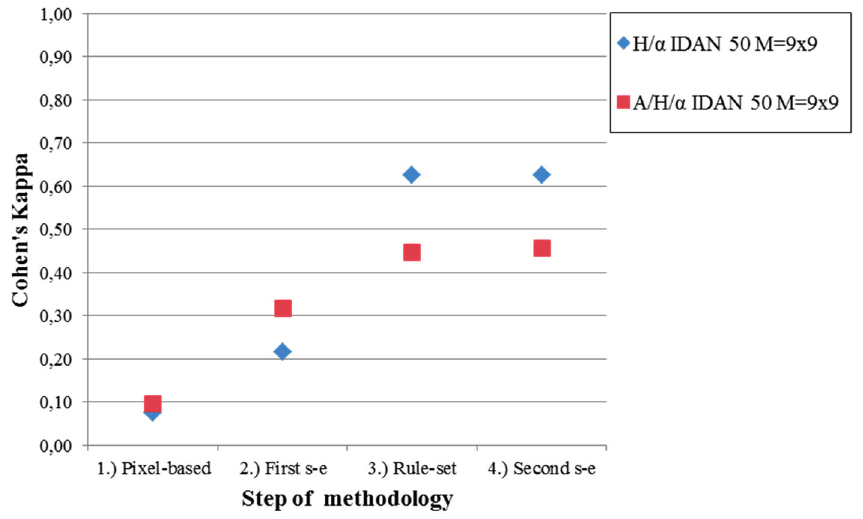
Figure 12. Development of the Cohen’s Kappa coefficient for the OBIA improvements based on H/ α or A/H/ α , respectively (for the second TerraSAR-X acquisition (19 October